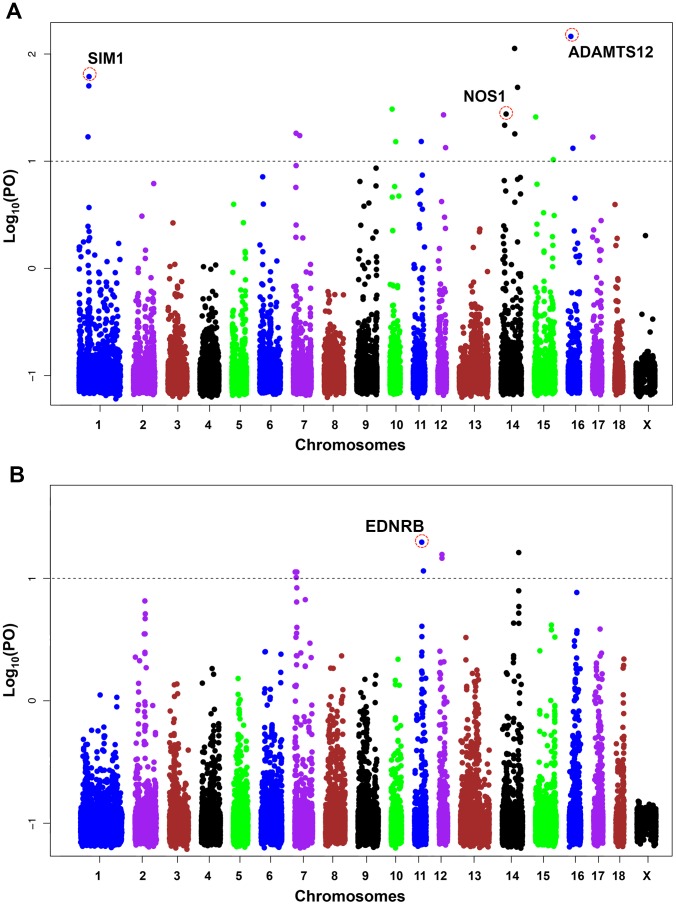
Genome-wide distribution of log10 Bayes factor values in two contrasts.(A) Tibetan pigs versus non-plateau pigs. (B) Belted pigs against non-belted pigs. The chromosomes are plotted along the x-axis, and log10 Bayes factor values are plotted along the y-axis. Chromosomes are indicated by different colors, and the threshold indicating signature of selection is denoted with a dashed grey line. In the upper panel, three highlighted genes that are likely involved with Tibetan high-altitude adaptation are circled in red, and the gene names are labeled above. For the contrast analysis between belted pigs and non-belted pigs, the top signal was detected at the EDNRB locus that is indicated in the lower panel.